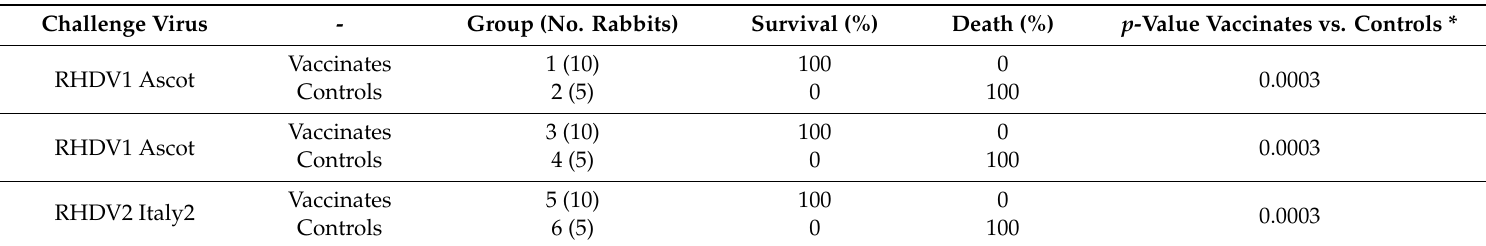
Table 9. Summary of mortality after RHDV challenge in DB rabbits. Challenge Virus - Group (No.